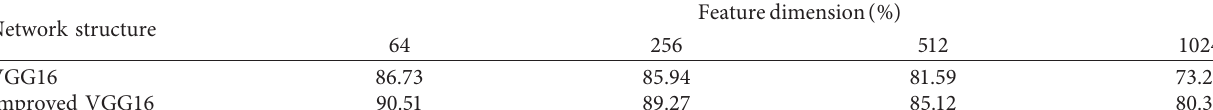
Table 1: Recognition accuracy of different feature